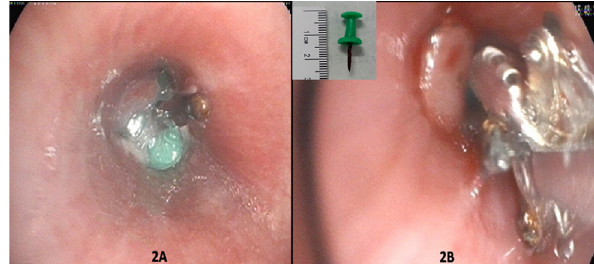
Figure 2: Bronchoscopic image. 2A: Metallic foreign body lodged in right lower lobe bronchus. 2B: Foreign body grasped with biopsy forceps. Inset showing the extracted push-pin.